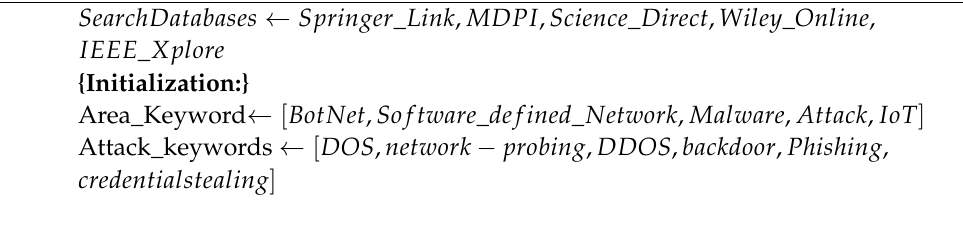
Algorithm 2: Pseudocode for Generating Potential Review